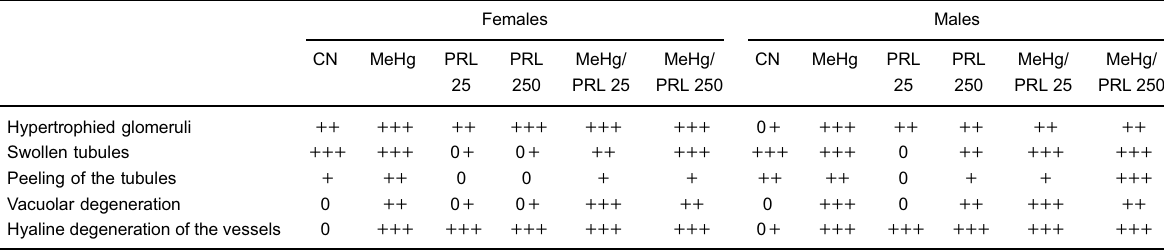
Table 2. Alterations observed in the kidney tissue of the mice of each treatment